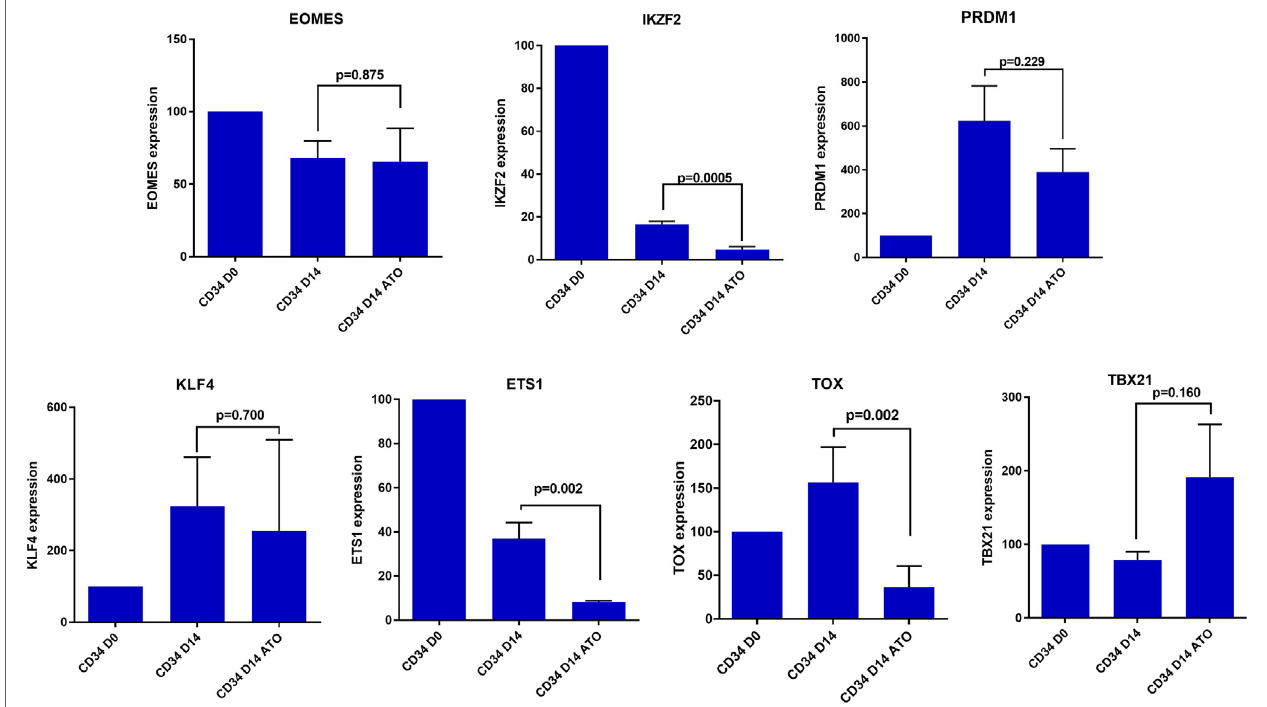
FigUre 8 | Expression of differentially expressed transcription factors involved in NK cell differentiation and maturation by RQ-PCR. The expression of the genes were determined by 2 ΔΔ CT method. The expression of these genes were normalized to GAPDH and the relative expression of genes on CD34 on day 14 ( ± ATO) was calculated with CD34 day 0 sample ( n = 3). p -value less than 0.05 was considered